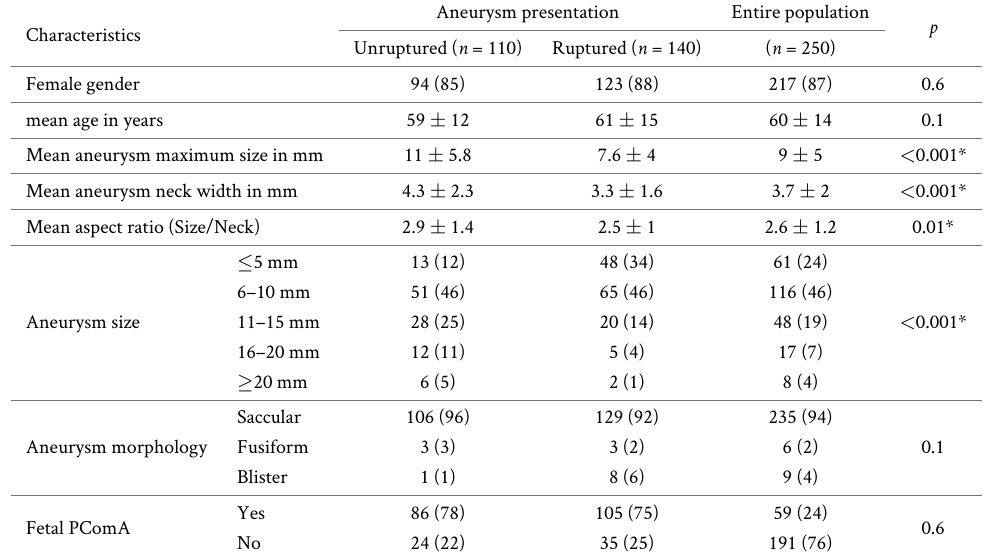
Table 1. Demographics and aneurysms’ characteristics split by aneurysm presentation (unruptured/ruptured).